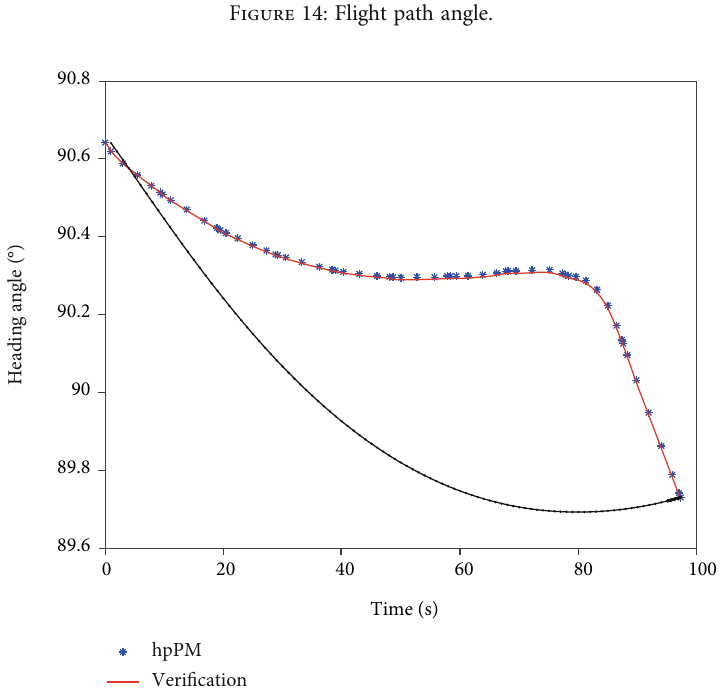
Figure 14: Flight path angle.